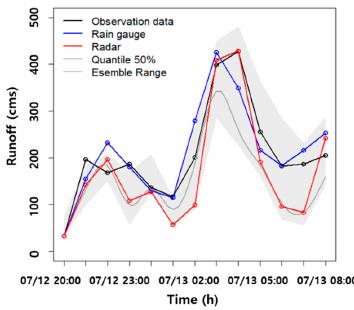
Figure 9. Runo ff hydrograph using SSARR. Figure 9. Runoff hydrograph using SSARR. Figure 9. Runoff hydrograph using SSARR. Figure 9. Runoff hydrograph using SSARR.